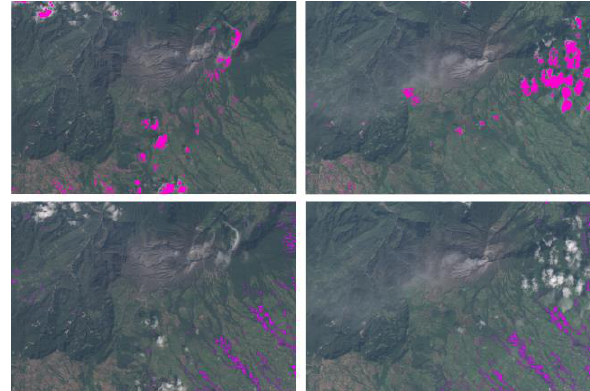
Figure 4. Example of occurrences maps of local shapes found in the discrete spectral profiles of two Sentinel 2 images. Maps highlighting clouds on 26/01/2017 (left up) and on 12/12/2018 (right up). Maps highlighting trees along brooks on 26/01/2017 (left down) and on 12/12/2018 (right down).